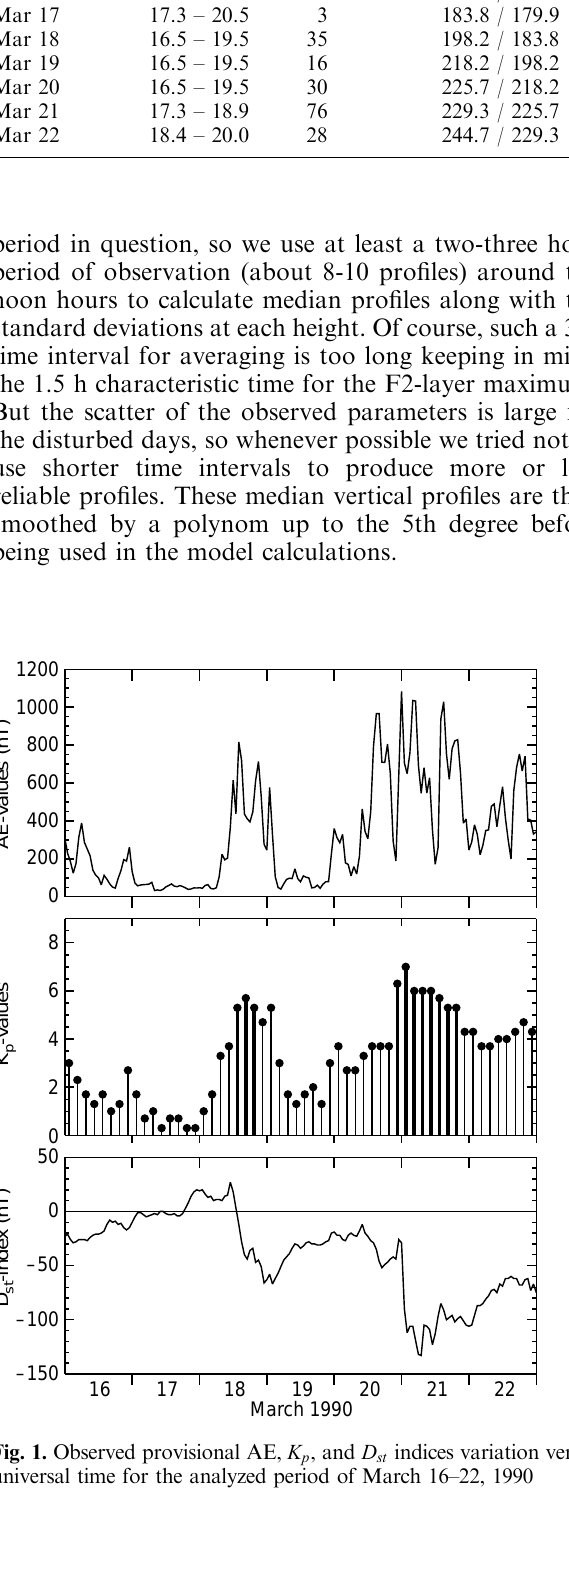
Fig. 1. Observed provisional AE, K p , and D st indices variation versus universal time for the analyzed period of March 16–22, 1990